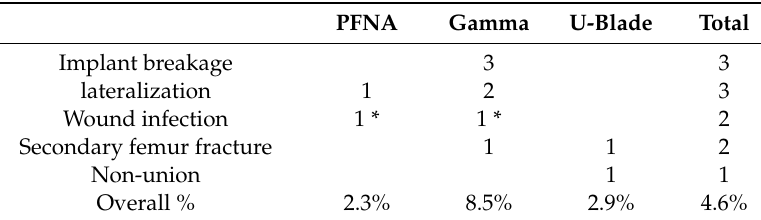
Table 4. Complications requiring surgical